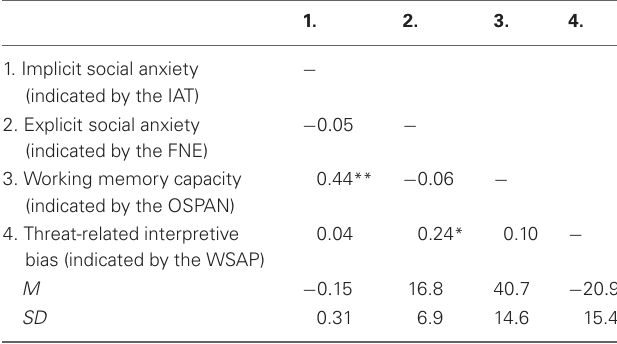
social anxiety, WMC, and threat-related interpretive bias, ( n =